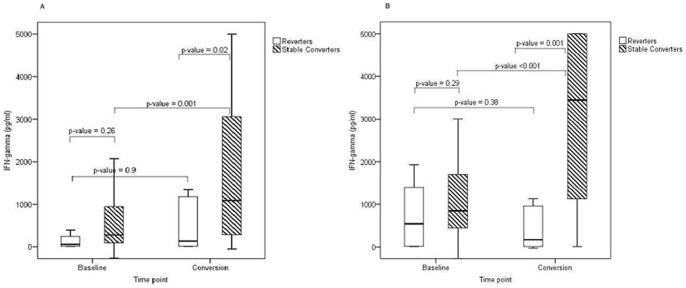
Longitudinal WB-IGRA results among HHC.Whole blood was obtained from a subset of eligible subjects at study enrollment (baseline) and time of initial TST conversion. WB-IGRA were performed using Mtb Ag85B (A) and whole Mtb H37Ra (B) as T cell stimulus. Boxes indicate the interquartile ranges, horizontal lines transecting boxes indicate medians, and whiskers indicate highest and lowest values. At study entry (baseline), no significant differences were noted between reverters and stable converters for either stimulus. At the time of conversion, subjects with stable conversion produced significantly more IFN-γ than reverters in response to both Mtb Ag85B and whole Mtb H37Ra (A, B). Moreover, IFN-γ production significantly increased among stable converters between enrollment and conversion, while there were no significant changes noted for reverters. Statistical comparison between groups was performed using Wilcoxon rank sum test, and comparison with groups performed with Wilcoxon sign-rank test (p< 0.05 considered significant).